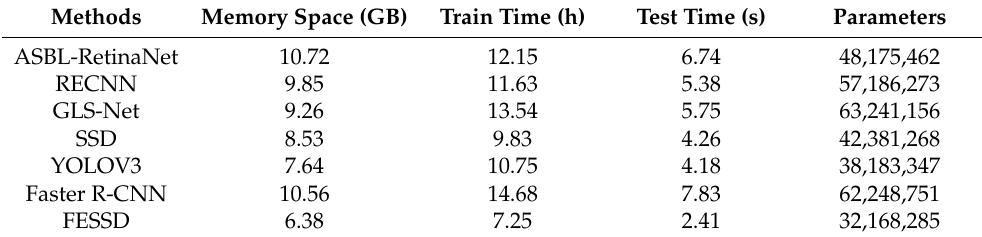
Figure 12. The effect of different attention mechanism on model performance. Table 6. The calculation efficiency comparison of different